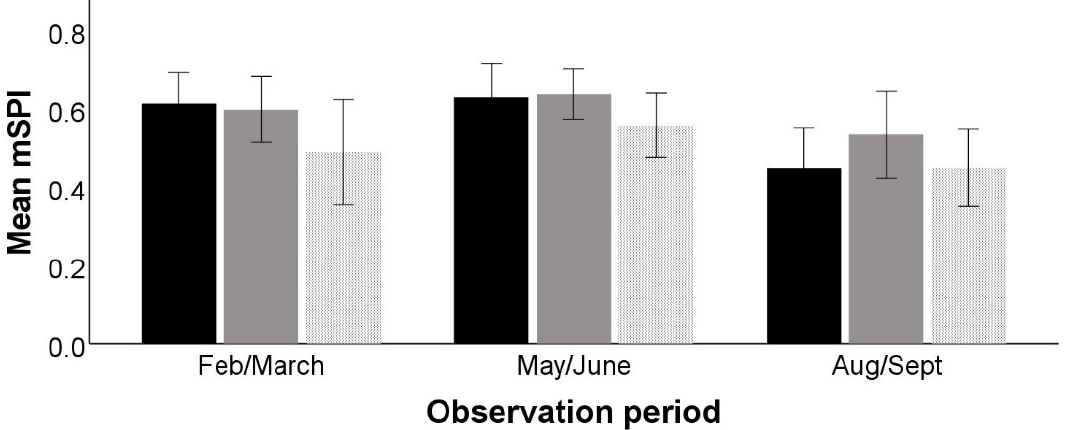
Figure 2. Modified spread of participation indices for the three time periods (black = AM, grey = midday, and dotted = PM) across the three observation periods (February–March, May–June, August–September). The figure shows a decrease in mSPI value across all time periods in the final observation period. Error bars represent the standard error of the mean. Post-hoc comparison tests showed a significant difference (mean difference = 0.131, SE = 0.032, p = 0.015) in mSPI between the 2nd and 3rd observation periods, May–June and